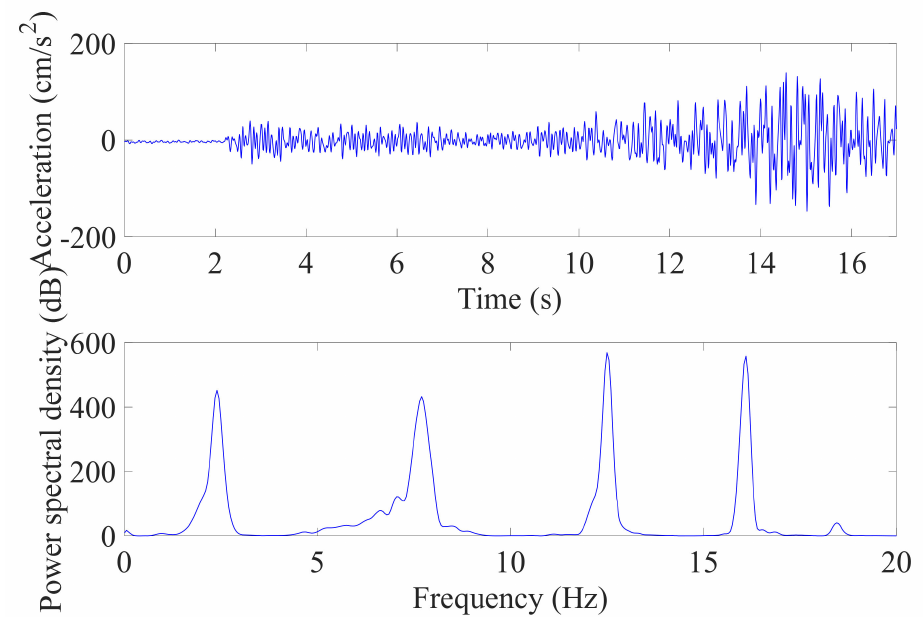
Figure 11. Absolute acceleration response and power spectral density of first floor.